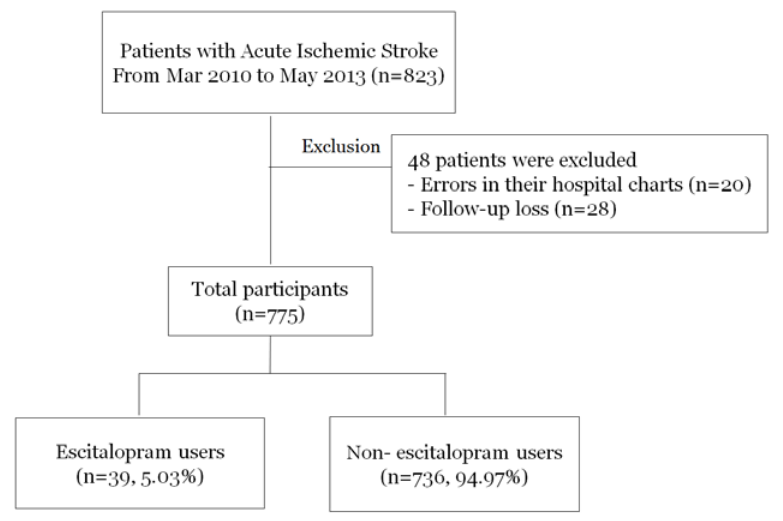
Figure 1. Study population.